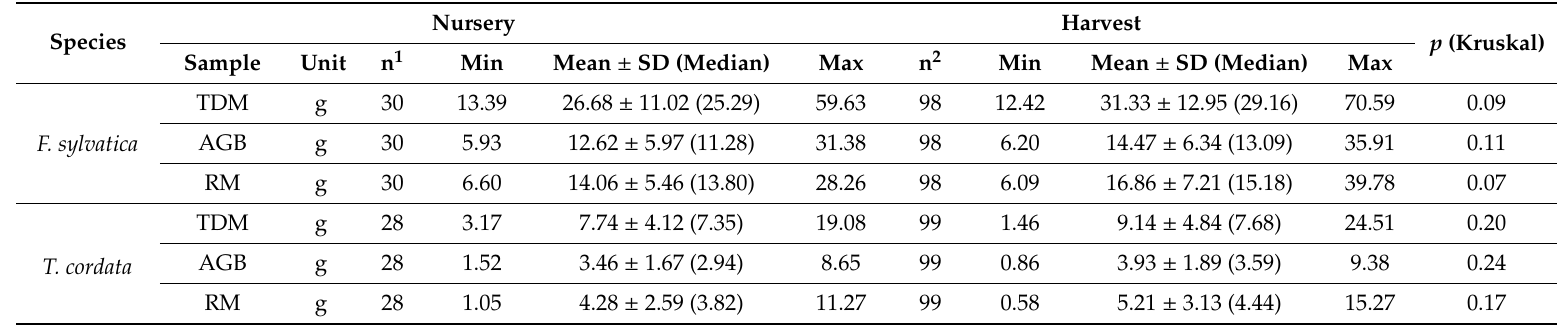
Table 2. Seedlings’ biomass before and after the growing season 2017. Total dry mass (TDM), aboveground biomass (AGB), and belowground biomass (RM) of F. sylvatica and T. cordata before (nursery) and after the first vegetation period (harvest) in g. The leaf weights from harvested seedlings were excluded from TDM and AGB. n 1 is the sample size of seedlings from the nursery, n 2 is the sample size of the harvested plants. Shown are minimum (Min), mean and standard deviation (SD), median, and maximum (Max)